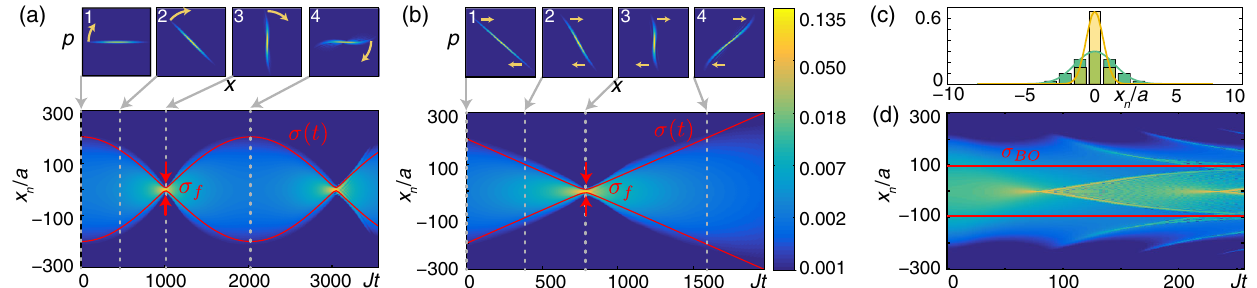
FIG. 2. Time evolution of an initially delocalized spin excitation on a lattice according to the spin-lens Hamiltonian Eq. (1) for the (a) thick and (b) thin lens for a 1D string of L ¼ 800 spins as a function of time t . The red line, σ ð t Þ , indicates the continuum result. Insets 1 – 4 above illustrate the dynamics of the Wigner function at four specific times. (c) Zoom to illustrate the final optimized spatial excitation probability per atom illustrating that focusing on the scale of (essentially) single atoms can be obtained. The green bars 2 . 7 a . The yellow bars correspond correspond to a focusing dynamics of the thick lens with initial width σ 0 ¼ 100 a and final width σ f ¼ 1 . 2 a . (d) Bloch oscillations in focusing dynamics to a second focusing stage with a thin lens starting with σ 0 ¼ 2 . 7 a to final width σ f ¼ at the edge σ of the lens (see BO